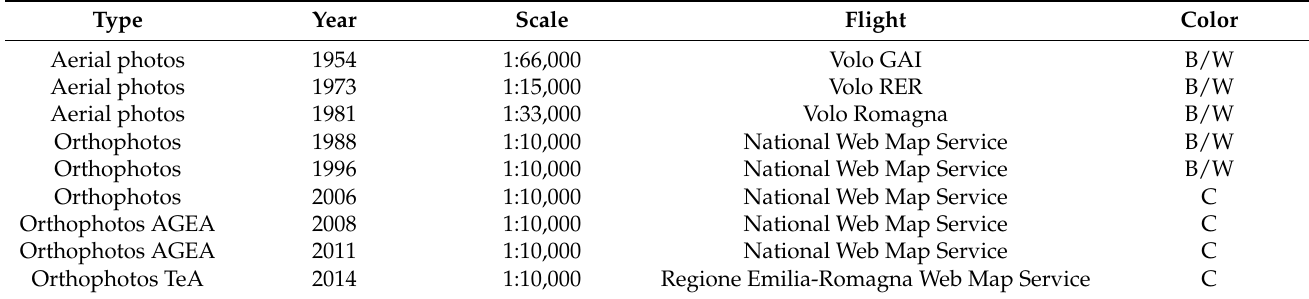
Table 2. Cartographic documents examined. GAI: Aerial Italian Group; RER: Emilia-Romagna Region; GN: Geoportale Nazionale website; AGEA: Agenzia per le Erogazioni in Agricoltura; TeA: Consorzio Telerilevamento Agricoltura; B/W: Black and white; C: